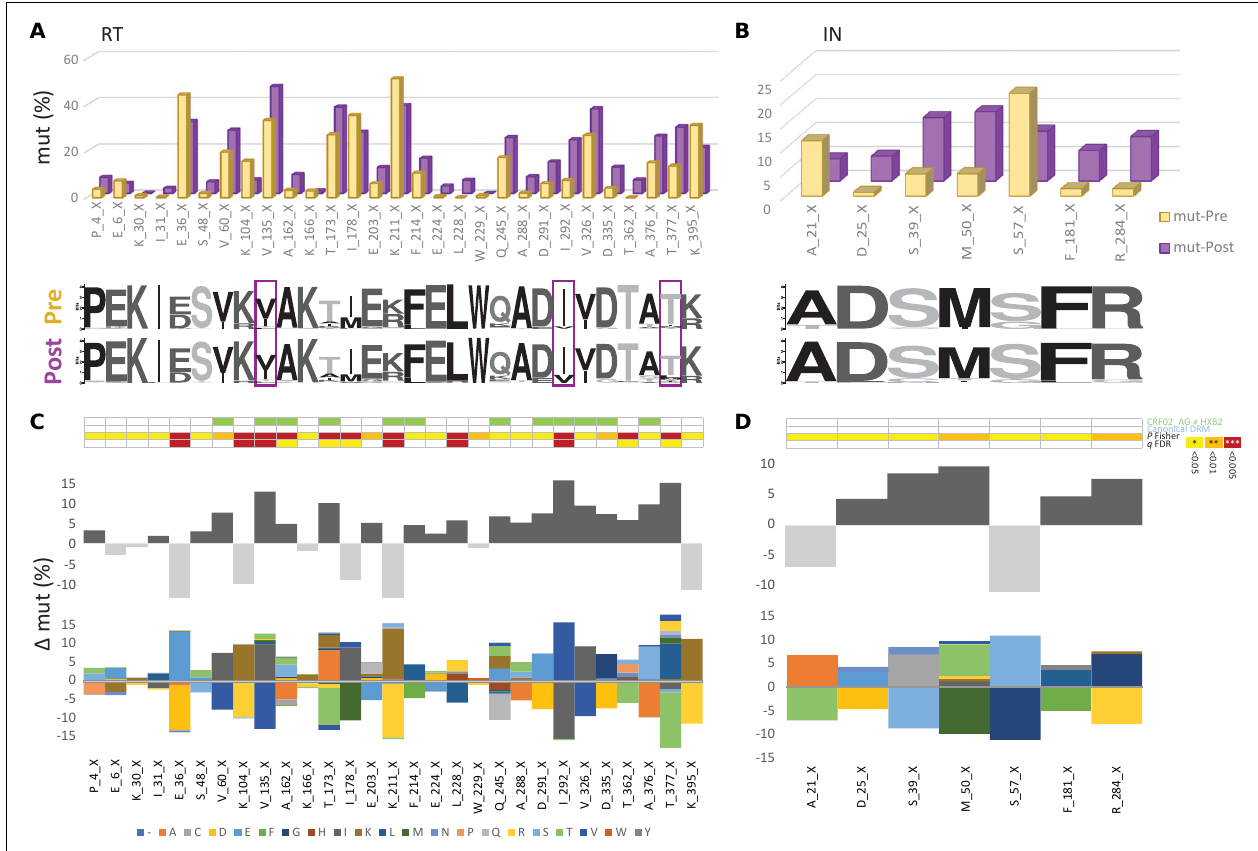
FIGURE 5 | The emergence of treatment-associated mutations in RT, but not in IN of Cameroonian HIV-1 CRF02_AG sequences during years of cART scale-up. (A,B) Comparison of site-specific frequencies in HIV-1 pol RT (left) and IN sequences (right) before (yellow, Pre) and after (purple, Post) regional implementation of cART. All sites are shown that have not been linked with canonical drug resistance and that exhibit changes in mutation (mut) frequencies from to Pre to Post yielding P values < 0.05 [see also (C,D) ]. CRF02_AG consensus sequences (derived from pre-cART data sets) served as references to call mut variants per site. The dominant (consensus) amino acid is indicated for each site, followed by the position in RT. X indicates any mutation/minority variant. Below the bar chart, weblogos of amino acid occurrences per site are indicated from both Pre and Post data sets. Sites at which mutation frequencies increased by more than 10% from the pre- to post-cART period are boxed. (C,D) Same selection of RT and IN sites as in (A,B) . On the y-axis, the difference in mut percentage ( (cid:49) mut) between Post and Pre is indicated for each site, with increasing mut frequencies from Pre to Post shown as positive values (dark gray bars) and decreasing frequencies shown as negative values (light gray bars). The mirror bar chart below indicates all amino acid (aa) changes according to the aa color code at the bottom. The 4-row color strips on top indicate differences between CRF02_AG consensus sequences and HxB2 (green), sites of canonical drug resistance mut (DRM) sites (blue), and statistically significant differences between Pre and Post in Fisher Exact tests ( P values) and false discovery rates (FDR, q values), according to the legend to the